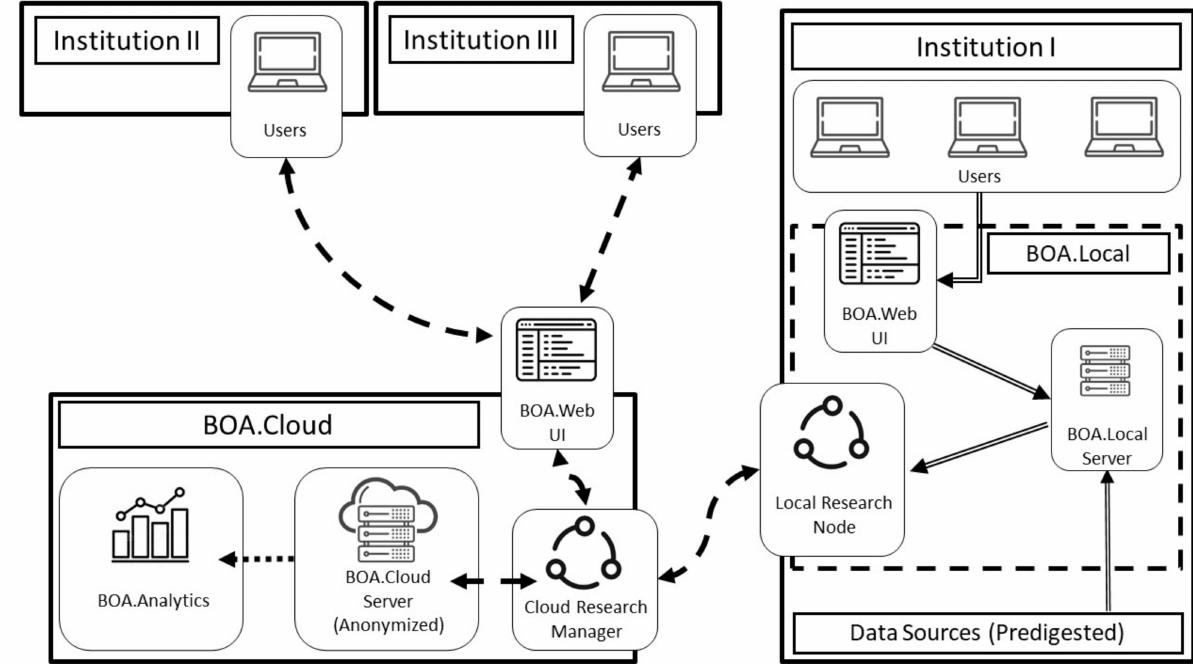
Figure 1. General beyond awareness ontology (BOA) architecture, with both the BOA.Local and BOA.Cloud servers. An infinite number of external institutions without a BOA.Local installation can be added at needed to this infrastructure. Double-line arrows represent non-anonymized patient data, dashed arrows represent anonymized patient data, and dotted arrows represent aggregate